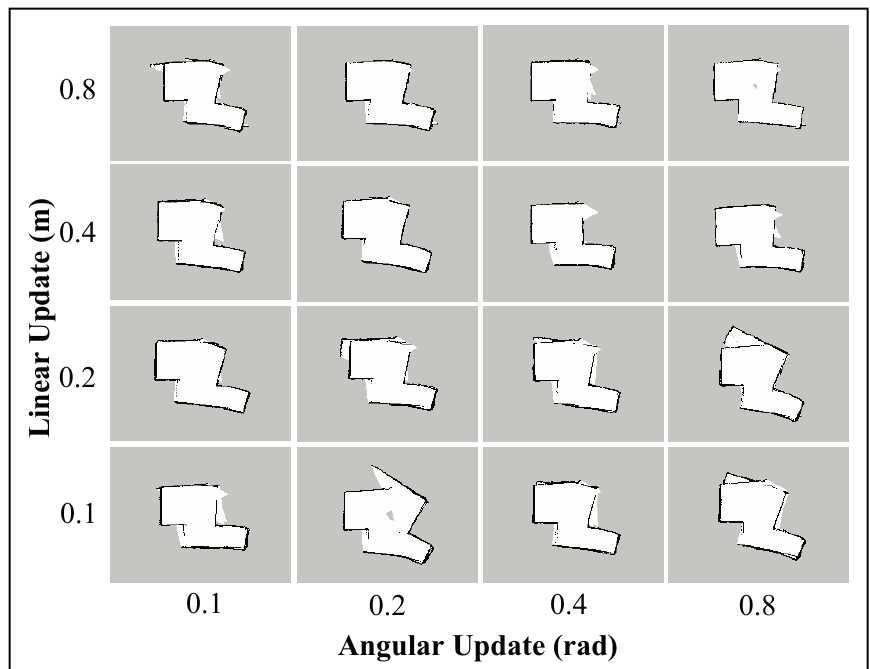
Figure 13. Room maps obtained using Gmapping technique with different combinations of Linear and Angular Update